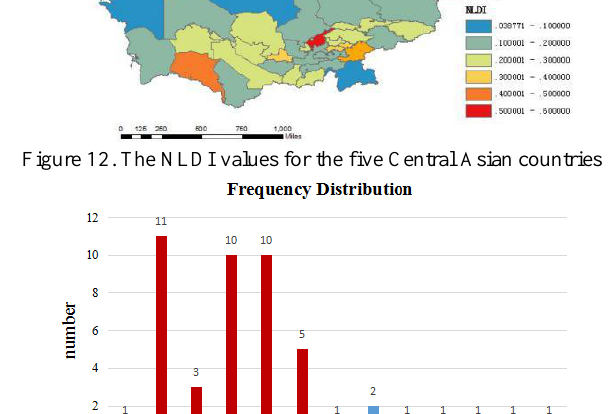
Figure 13. Frequency distribution of NLDI As seen in Figure 12, Kazakhstan and the eastern part of Kyrgyzstan have the minimum NLDI value, while Uzbekistan's capital Tashkent has the highest value, followed by Turkmenistan's Ahhal. However, the development of most states Figure 13